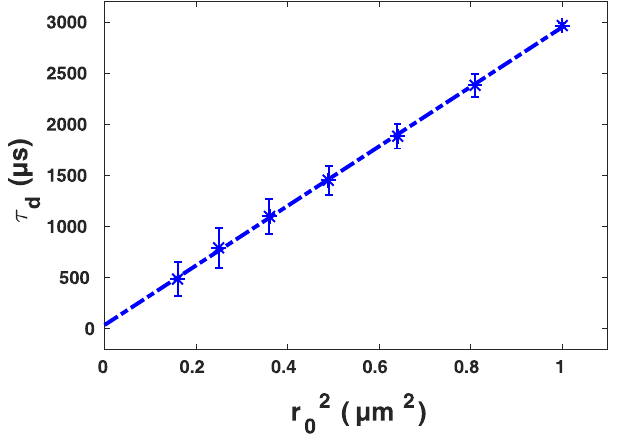
Figure 11. Diffusion time of AlexaFluor647-labeled streptavidin in pure DMSO versus size, together with 02 with Pearson r 2 = 0.999. Data are presented as means ± standard deviation from linear fit of τ = + r 2, 912 35 d N = 4 independent experiments.